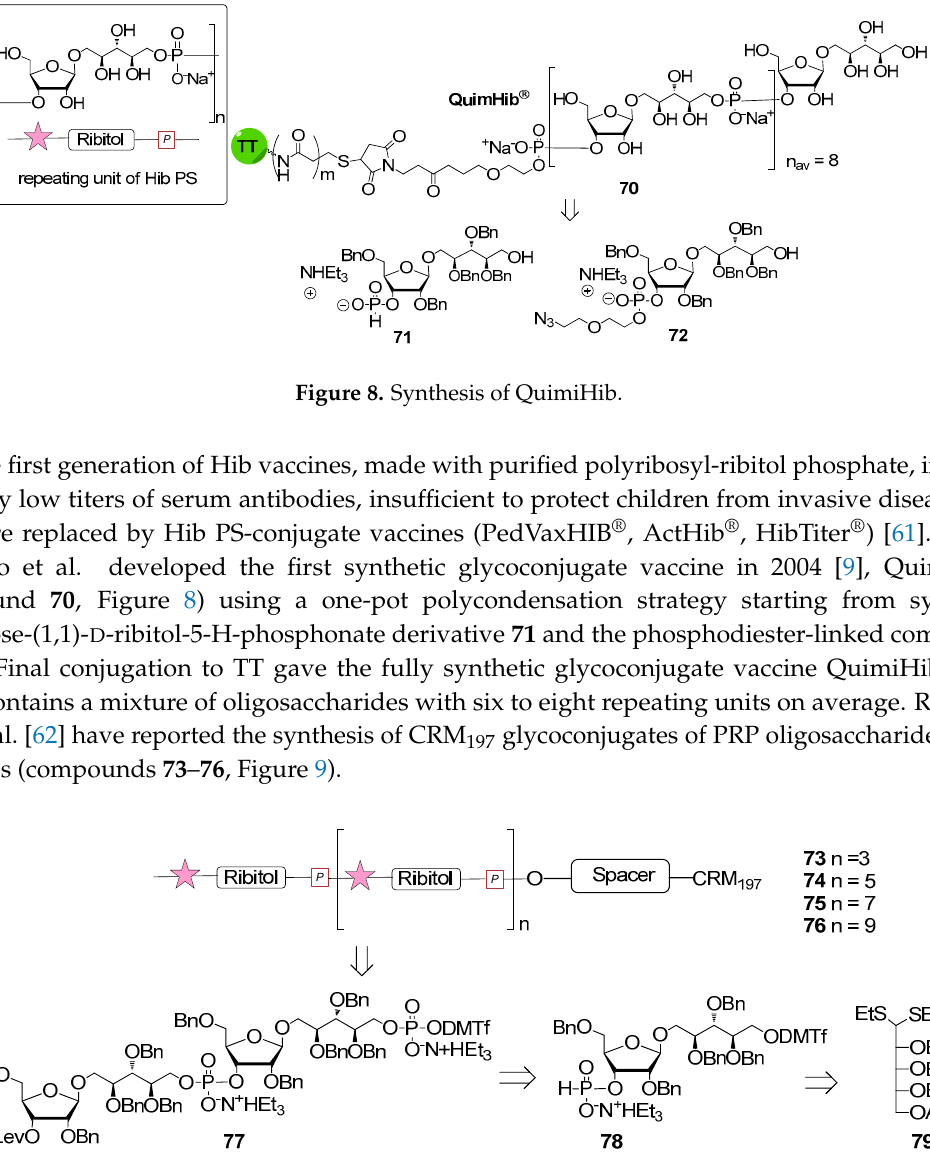
Figure 9. Haemophilus influenzae type b PRP oligosaccharides reported in [63].